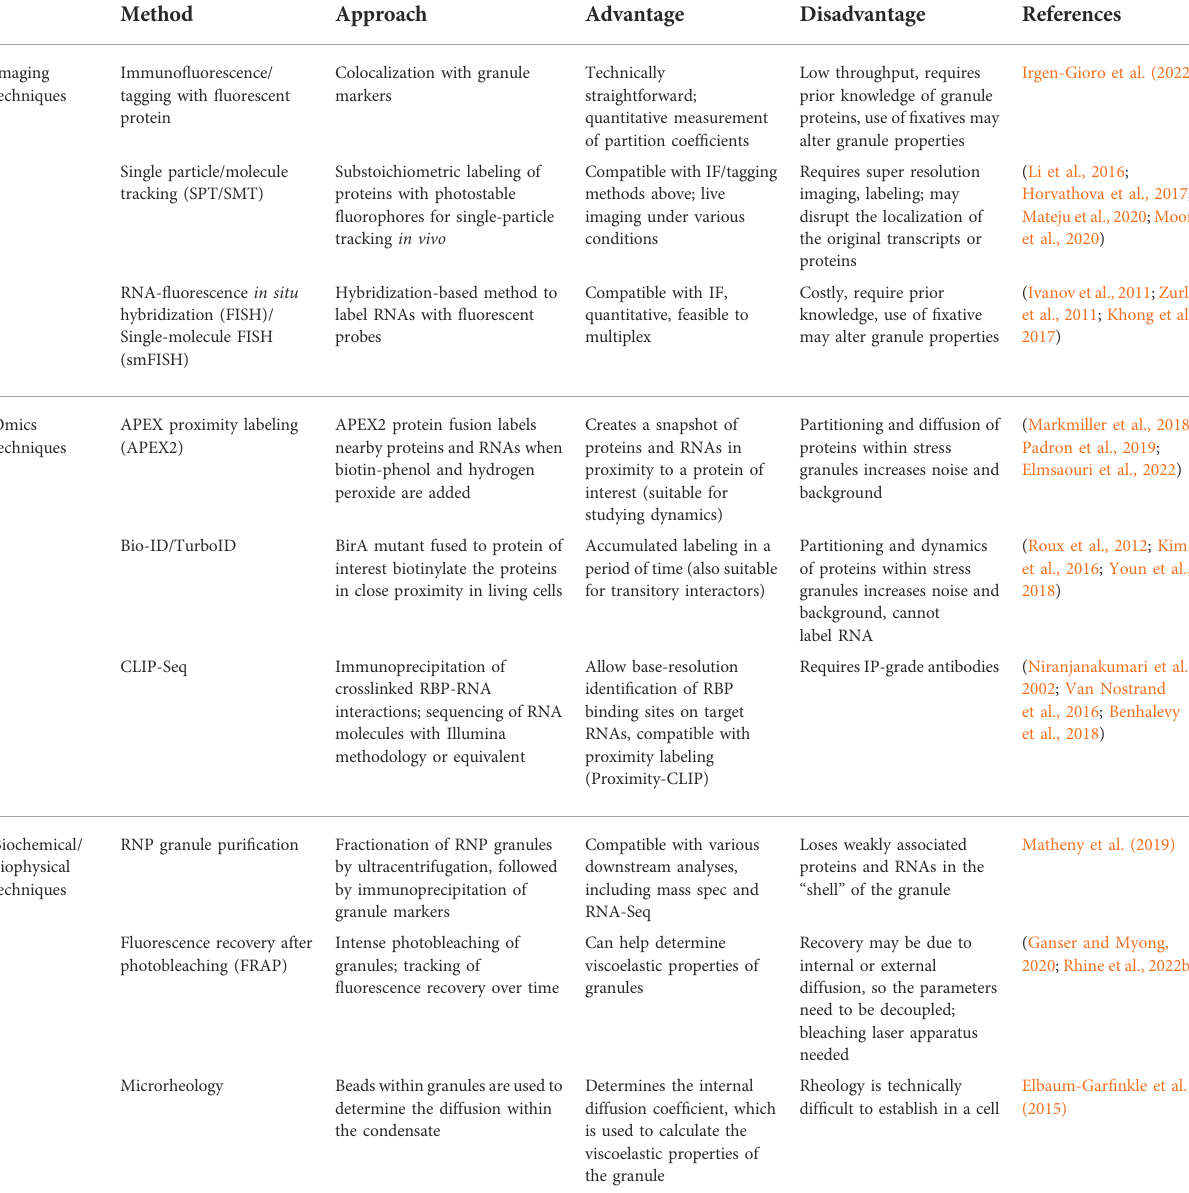
TABLE 1 Imaging, sequencing, and biochemical methods for studying RNA